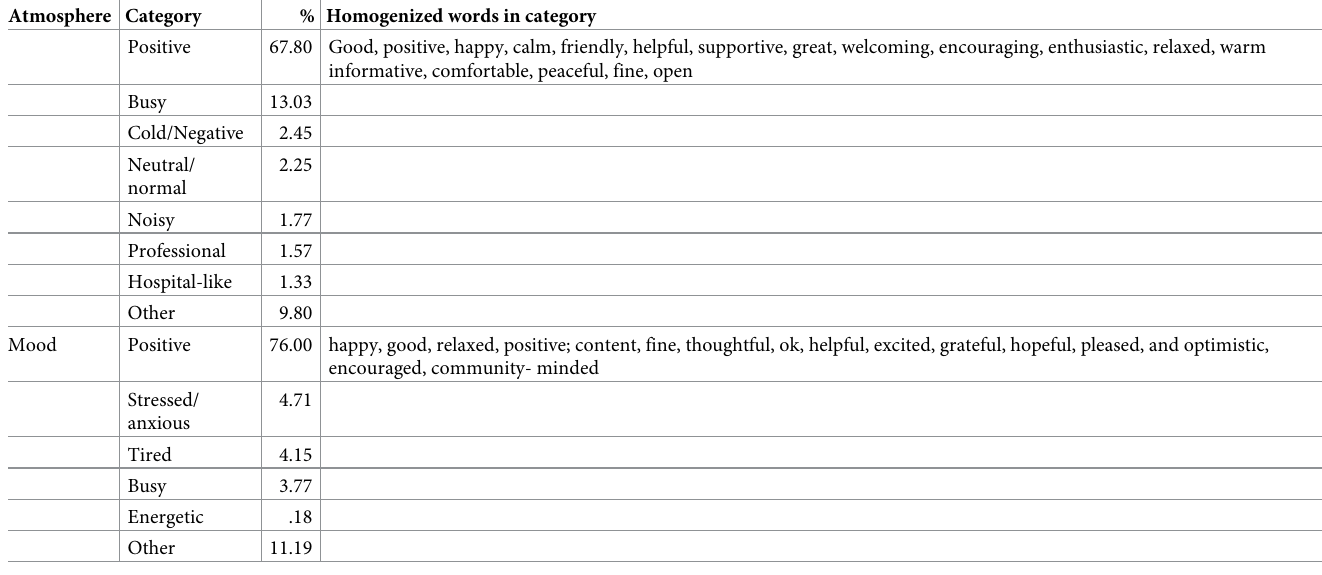
Table 7. Categorized elicitations with percentage